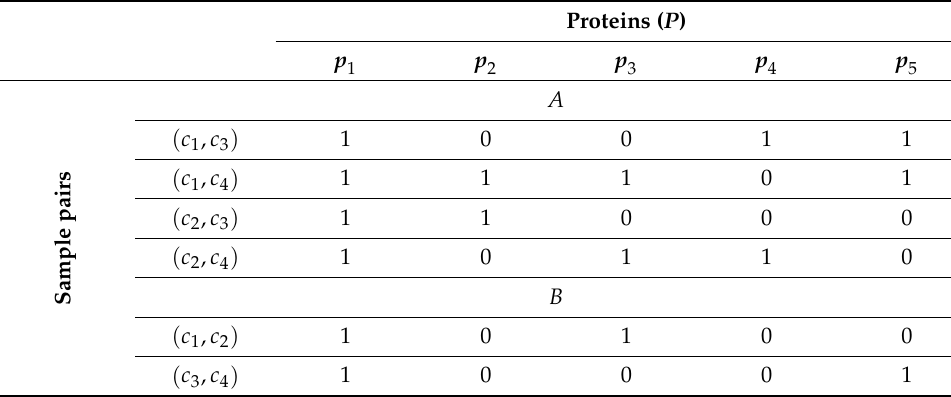
Table 2. Matrices A and B for the data of Table 1.